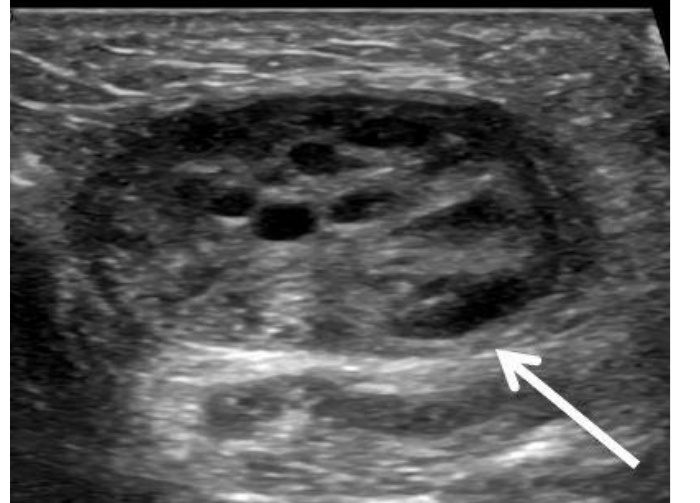
Image 2. Ultrasonography (sagittal view) showing an incarcerated ovary (arrow) within an inguinal hernia.